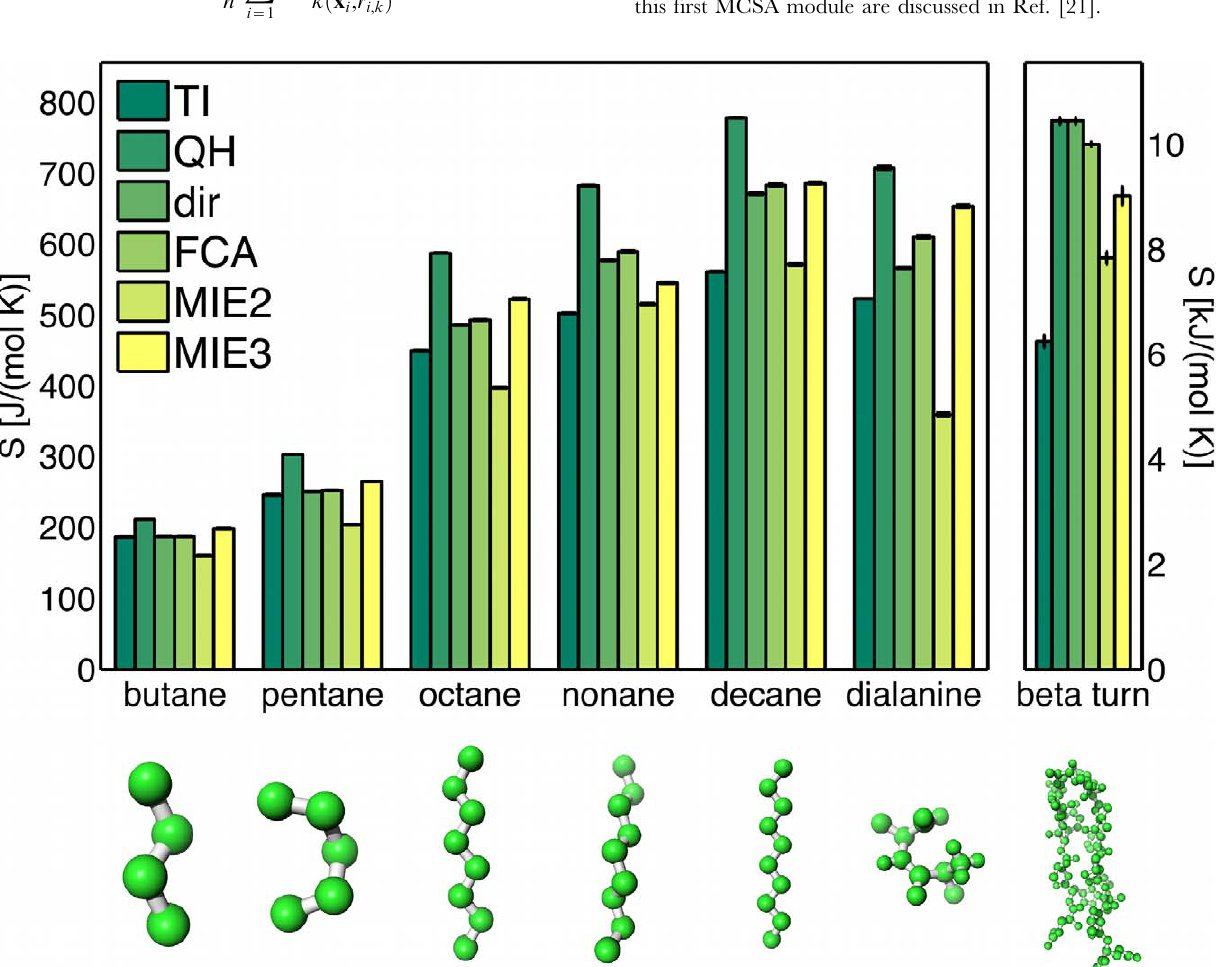
Figure 1. Entropy estimates for a set of small test systems. Five selected alkane systems, dialanine (left), and the C-terminal b { turn of Protein G (right, please note that here the units are kJ/(mol K)). Thermodynamic integration (TI), density estimates over the whole configurational space (dir), full correlation analyis with subsequent clustering and kernel density estimation (FCA), quasi-harmonic (QH) and mutual information expansion estimates of 2nd (MIE2) and 3rd (MIE3) order were obtained as described in the text.